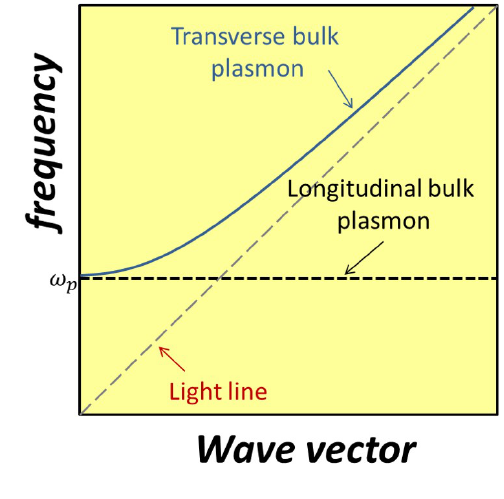
Figure 2. Photon and plasmon